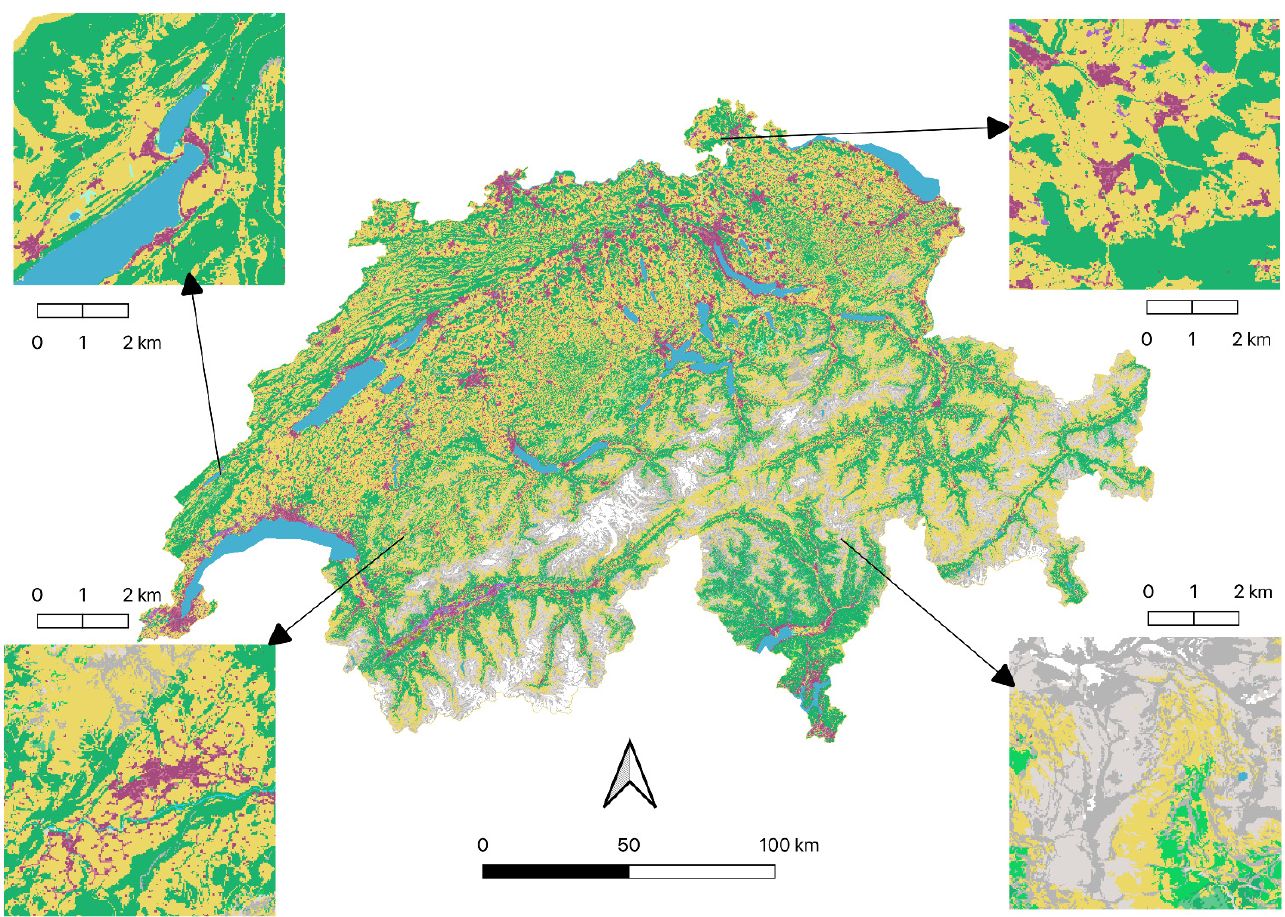
Figure 2. LC information with 29 classes from the National Base Map swissTLM3D for 2021.